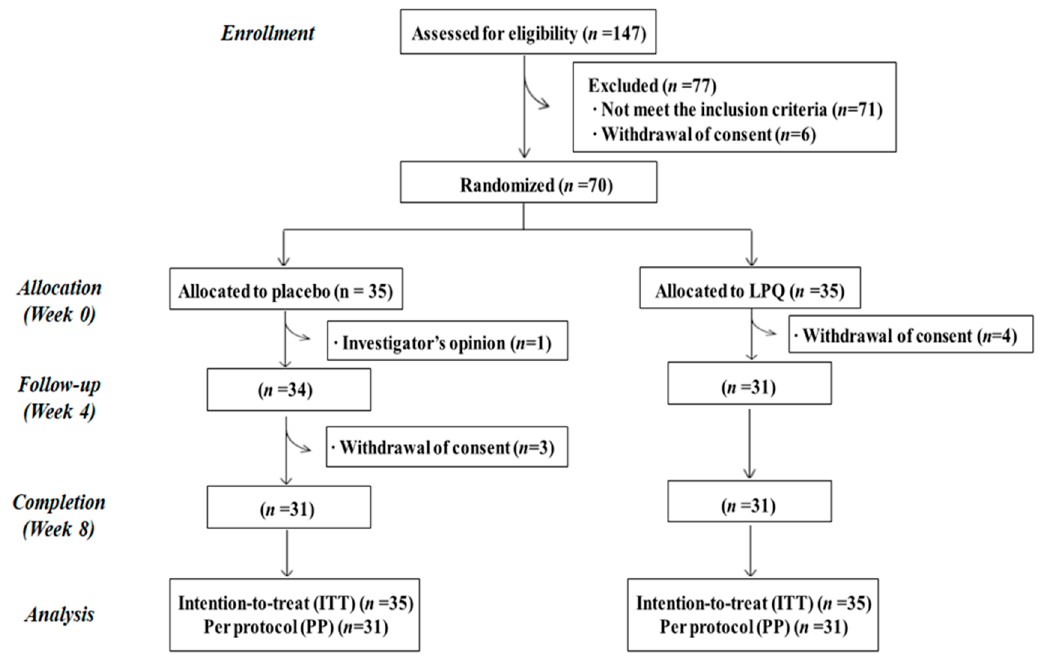
Figure 1. Flow chart of registered participants for the clinical trial.